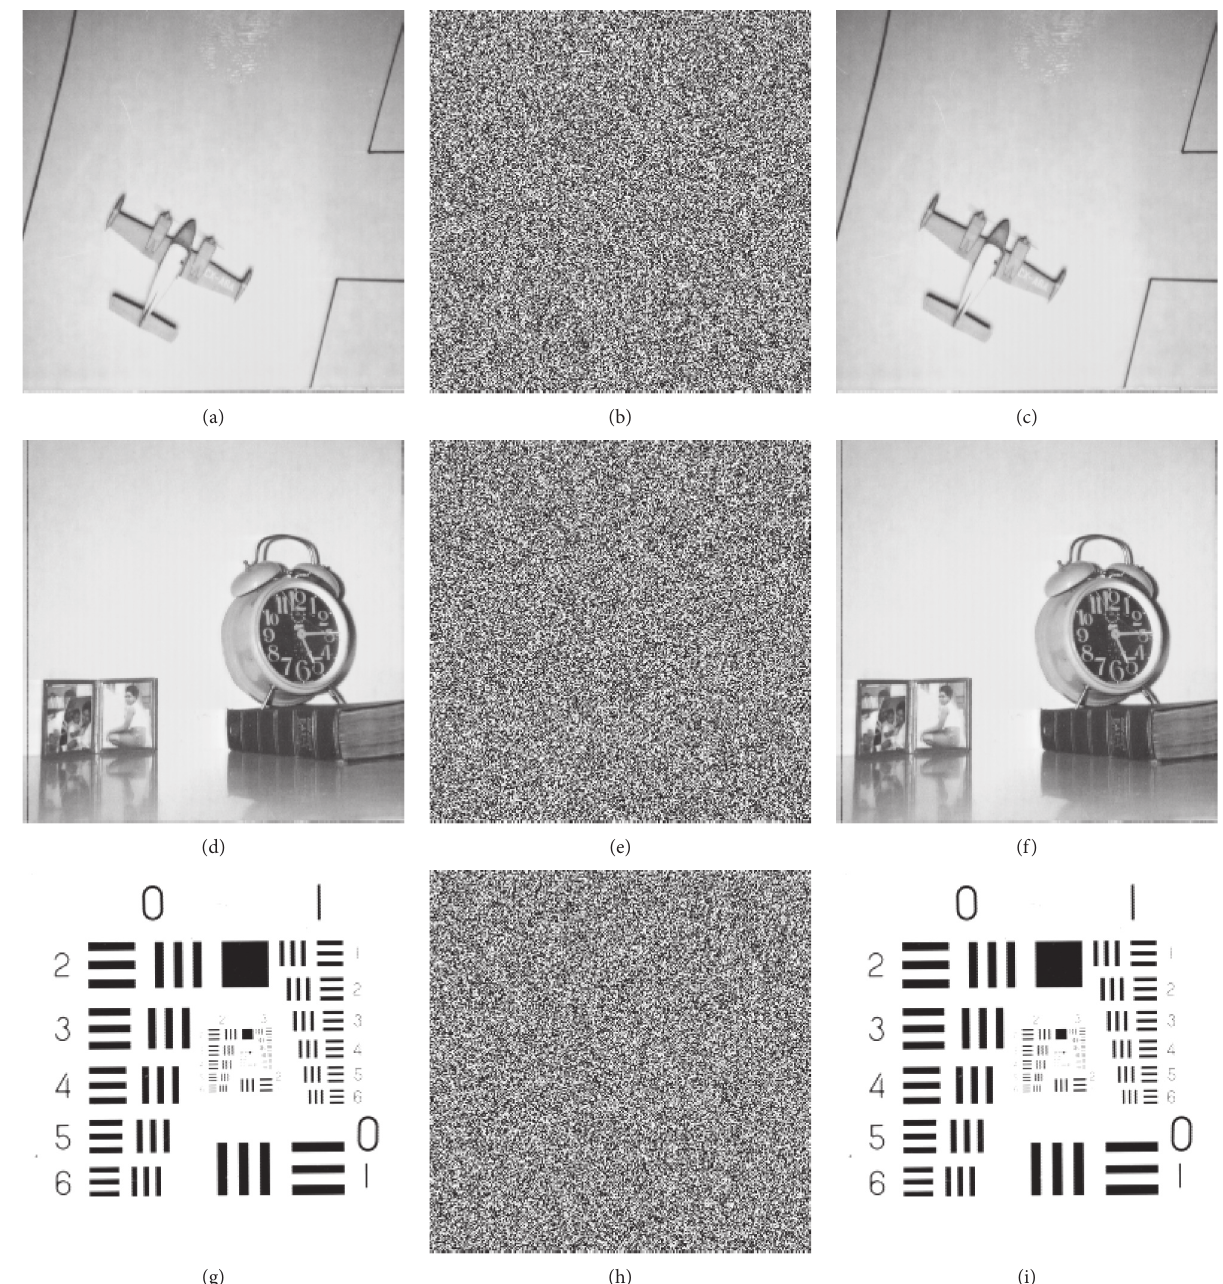
Figure 6: Numerical experimental results: (a, d, g) plain images 5.1.11.tiff, 5.1.12.tiff, and 5.1.13.tiff; (b, e, h) encrypted images corresponding to (a), (d), and (g); (c, f, i) recovered images corresponding to (b), (e), and